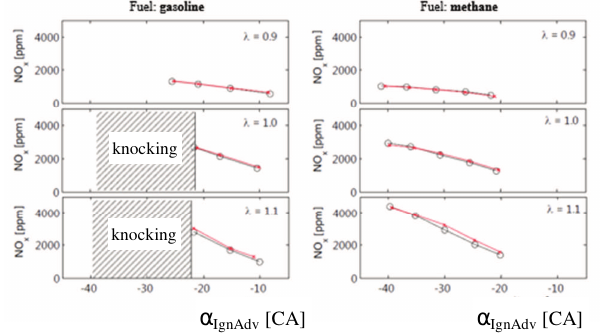
Fig. 9. Nitrogen oxides concentration in the exhaust gas of petrol and methane fueled